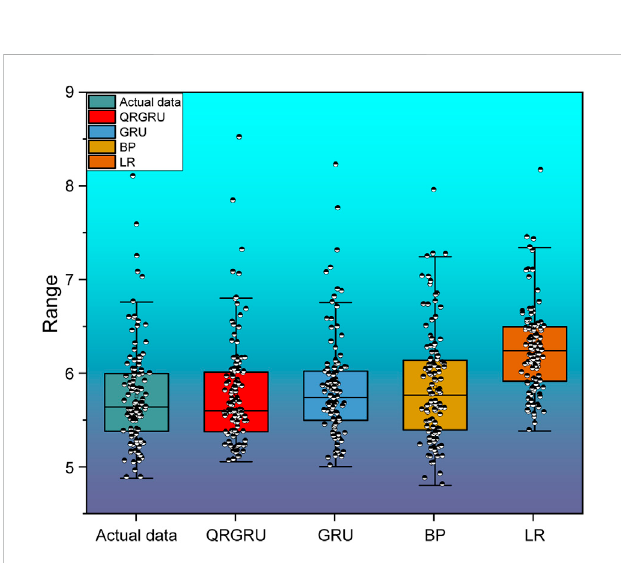
FIGURE 8 Boxplot of the distribution of predicted and true value data of four predictive models.